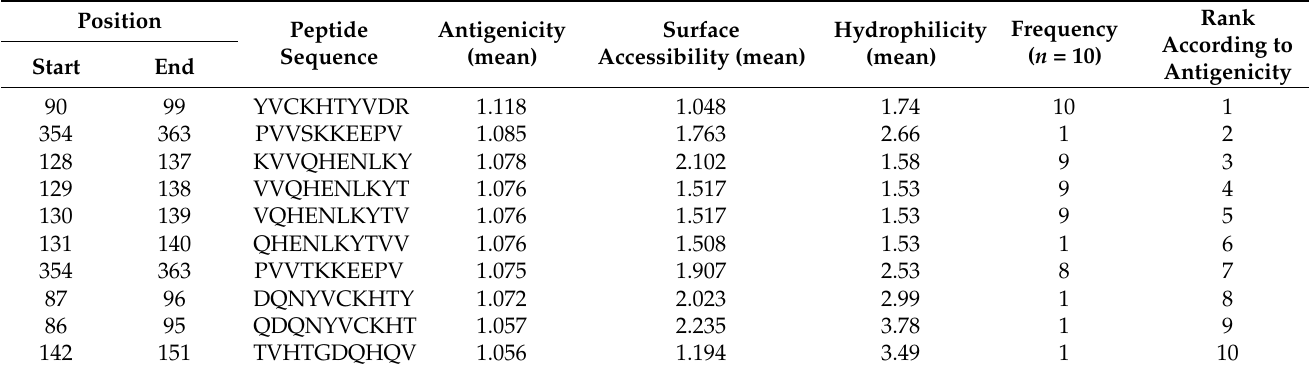
Table 3. Antigenicity, surface accessibility, hydrophilicity, and frequencies of top epitopes of DENV-3 E